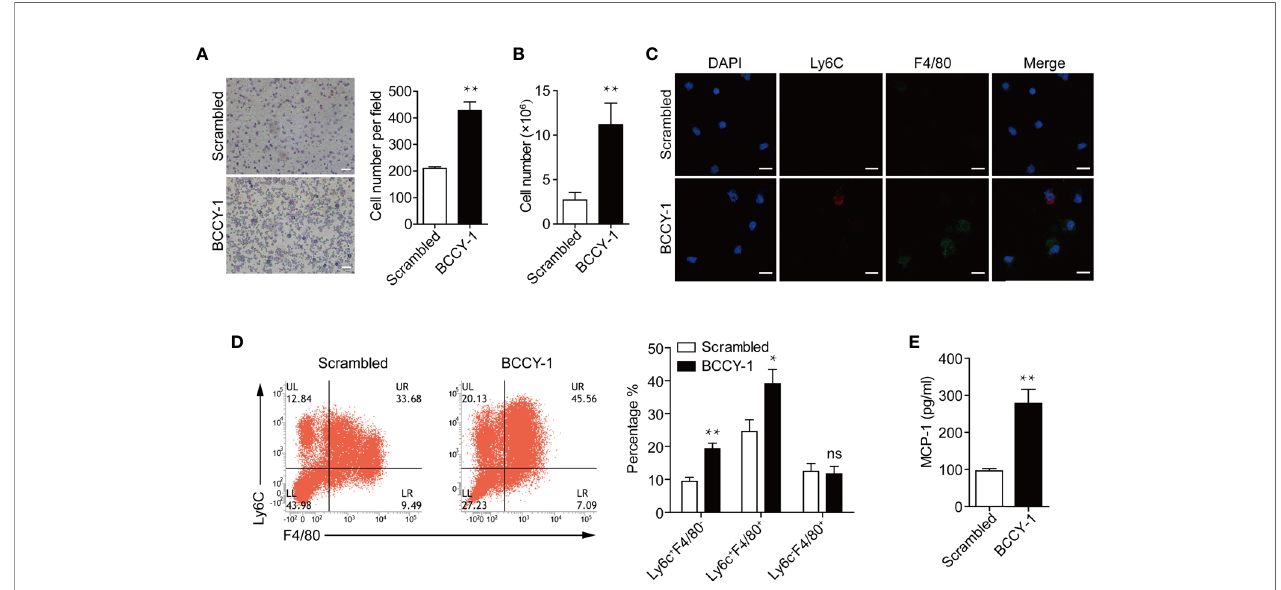
FIGURE 3 | Effects of BCCY-1 on monocyte recruitment in vivo . Monocyte recruitment into the peritoneum induced by peptide BCCY-1 (10 mg/kg) post i.p. injection was analyzed. The scrambled version of BCCY-1 served as a negative control. (A) Wright-Giemsa stain of peritoneal lavage fl uid after BCCY-1 or Scrambled peptide administration at 24 h. Bar=200 m m. The nucleated cell number per fi eld is shown as a bar graph in the right panel. ** p <0.01. (B) Cell number of peritoneal lavage cells after BCCY-1 or Scrambled peptide administration at 48 h. ** p <0.01. (C) Representative confocal images of peritoneal lavage cells after the indicated treatment are shown. Nuclei were stained with DAPI (Blue: DAPI; Red: Ly6C; Green: F4/80). Bar=20 m m. (D) Monocyte recruitment at 48 h post BCCY-1 injection was analyzed by fl ow cytometry using the following markers: Ly6C (monocytes), F4/80 (macrophages). Quanti fi cation of monocyte/macrophage percentage is shown as a bar graph in the right panel. ns p >0.05, * p <0.05, ** p <0.01. (E) Peritoneal lavage fl uids at 48 h after the indicated treatment were analyzed for MCP-1 production by ELISA. ** p